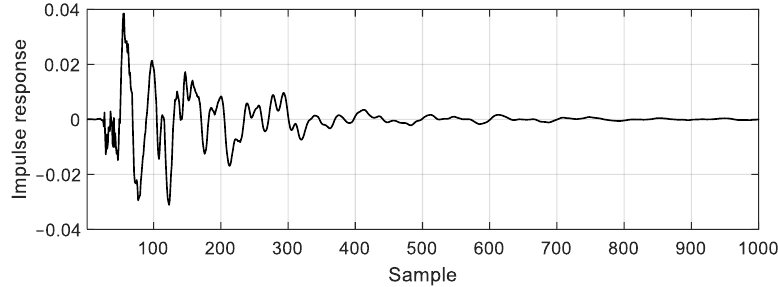
() S z . Figure 6. Impulse response of the nominal secondary path S 0 ( z ) 0